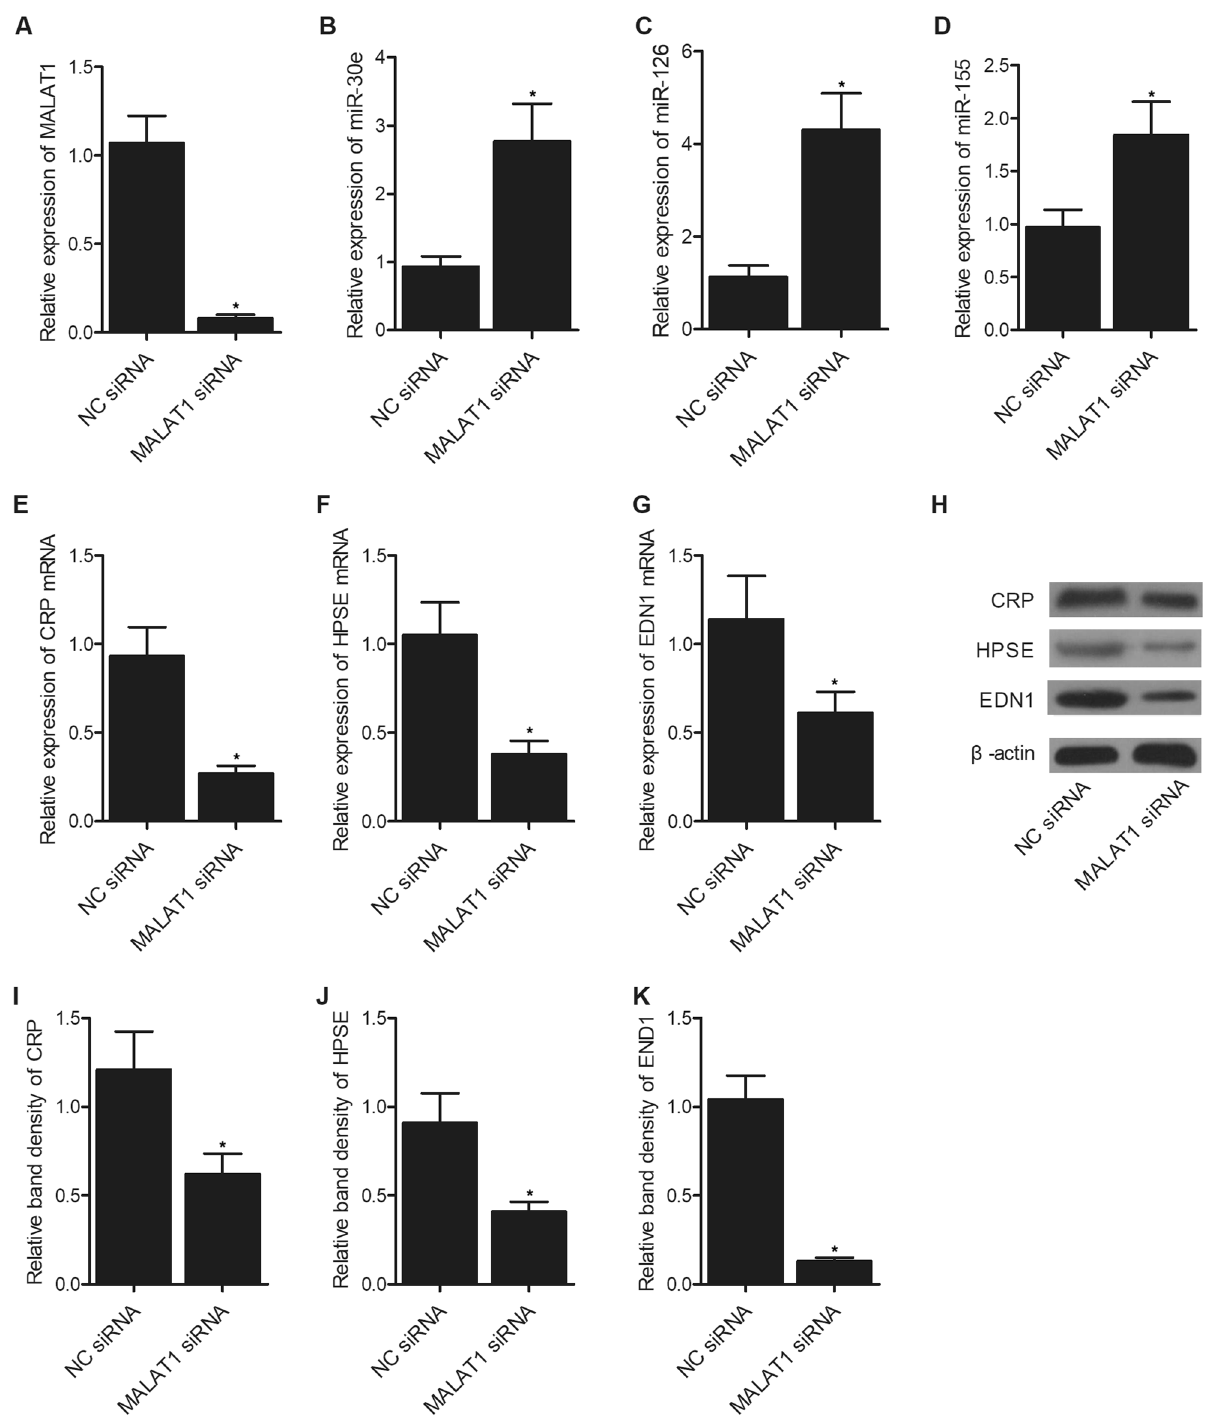
Figure 4. MALAT1 siRNA altered the expression of miR-30e, miR-126, miR-155, CRP, HPSE and EDN1 in HUVEC and HAEC cells (*P value < 0.05 vs. NC siRNA). ( A ) MALAT1 siRNA dramatically suppressed the expression of MALAT1 in HUVEC and HAEC cells. ( B ) MALAT1 siRNA notably enhanced the expression of miR-30e in HUVEC and HAEC cells. ( C ) MALAT1 siRNA notably enhanced the expression of miR-126 in HUVEC and HAEC cells. ( D ) MALAT1 siRNA notably enhanced the expression of miR-155 in HUVEC and HAEC cells. ( E ) MALAT1 siRNA remarkably suppressed the expression of CRP mRNA in HUVEC and HAEC cells. ( F ) MALAT1 siRNA remarkably suppressed the expression of HPSE mRNA in HUVEC and HAEC cells. ( G ) MALAT1 siRNA remarkably suppressed the expression of EDN1 mRNA in HUVEC and HAEC cells. ( H ) Western blot analysis showed that the protein expression of CRP, HPSE and EDN1 was suppressed by MALAT1 siRNA in HUVEC and HAEC cells. ( I ) Quantitative analysis showed that the protein expression of CRP was suppressed by MALAT1 siRNA in HUVEC and HAEC cells. ( J ) Quantitative analysis showed that the protein expression of HPSE was suppressed by MALAT1 siRNA in HUVEC and HAEC cells. ( K ) Quantitative analysis showed that the protein expression of EDN1 was suppressed by MALAT1 siRNA in HUVEC and HAEC